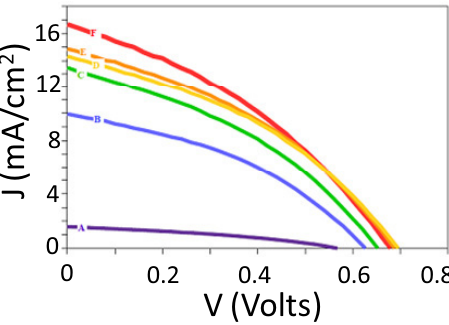
Fig. 6. J - V characteristic of the DSSCs utilizing photoanodes with different nanograin size, namely bigger grain size (A) to smaller (F), under A.M1.5, 100 W illumination.